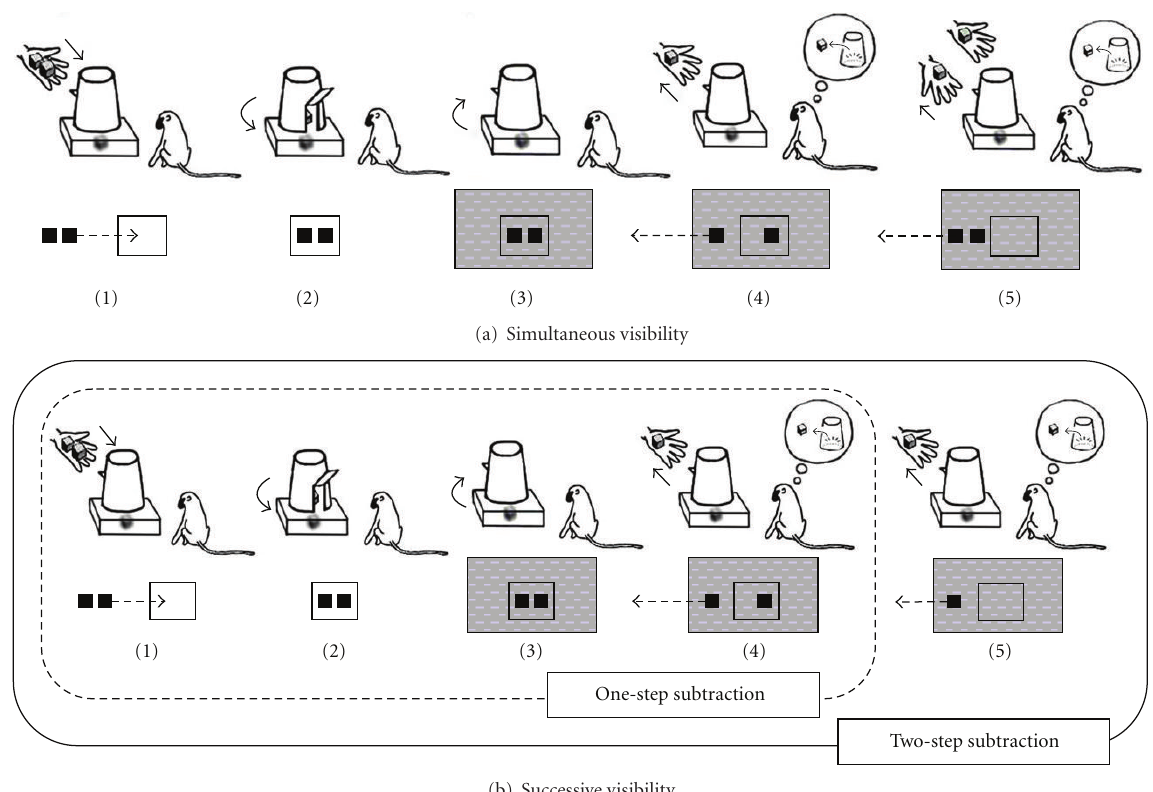
Figure 3: Subtraction sequences for the “2 − 1 − 1” (a) and “(2 − 1) − 1” (b) conditions. The upper row shows the actual movement of the cup and bread pieces, and the lower row indicates the hypothesized view (1, 2) and representation (3, 4, 5) of bread pieces in the monkey’s mind for each